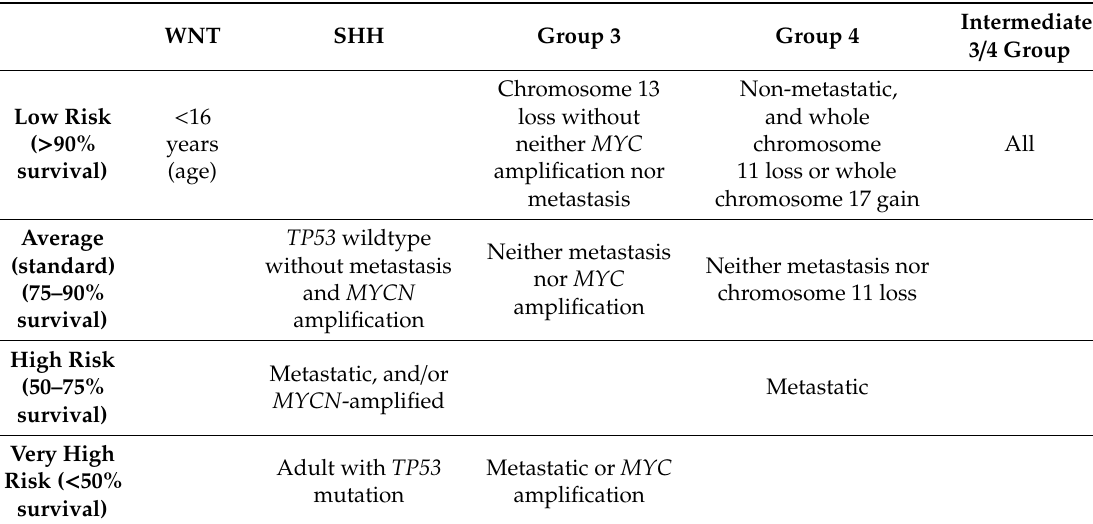
Table 2. Risk stratification of MB